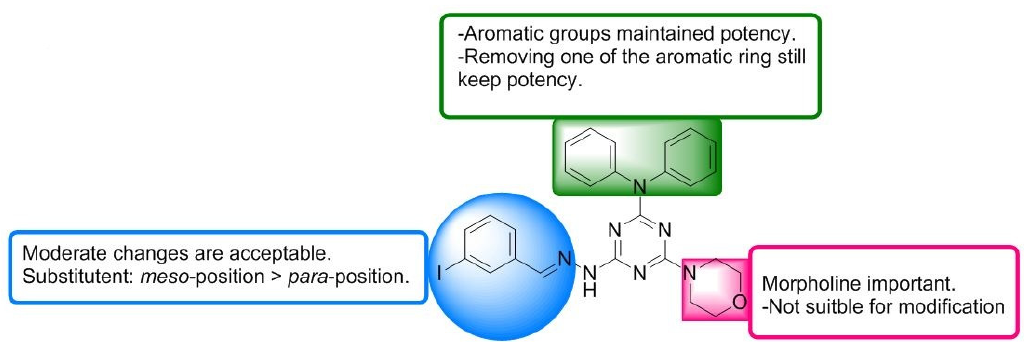
Figure 6. Structure-activity relationship for vacuolin-1 analogues as autophagy inhibitors.